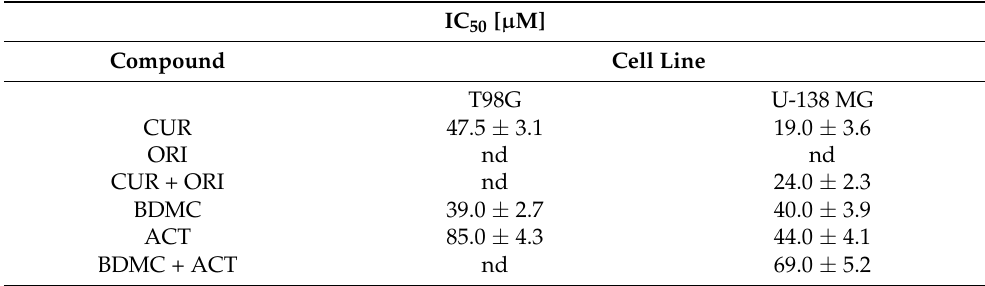
Table 4. The IC 50 values of CUR, ORI, BDMC, ACT, and their combinations dissolved in DMSO. Data are expressed as the mean ± SD from three independent